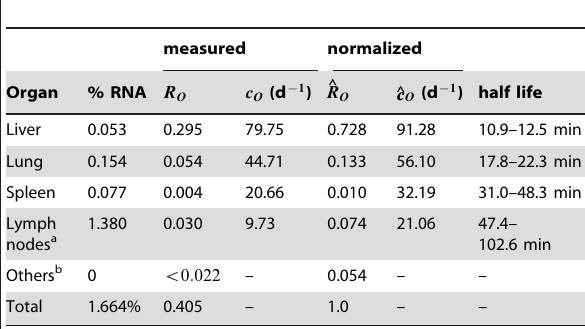
Table 1. The fraction of a bolus injection of SIV going into an organ after two hours, and the clearance rate in that organ estimated by Eqs.